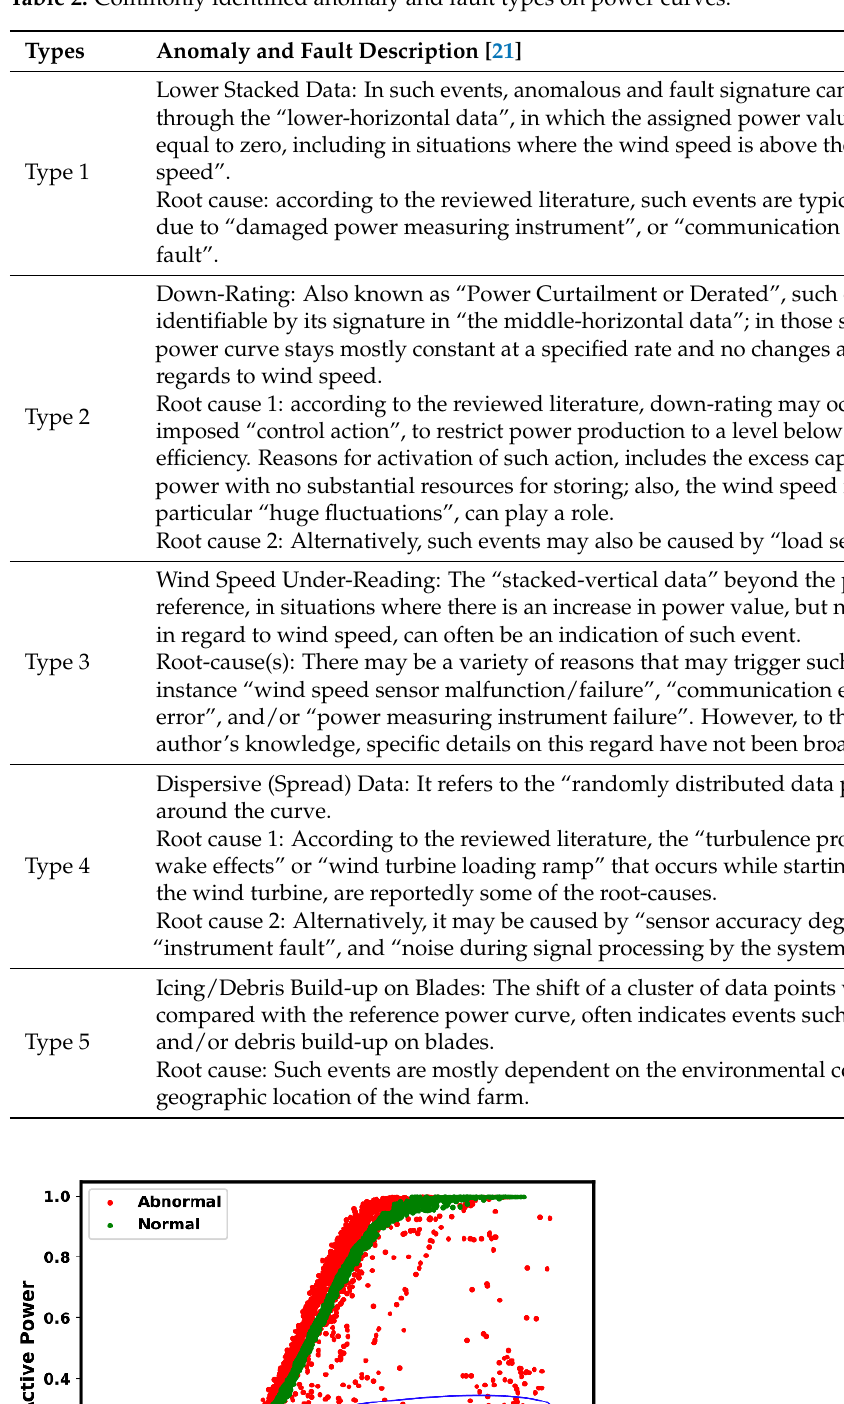
Table 2. Commonly identified anomaly and fault types on power curves.